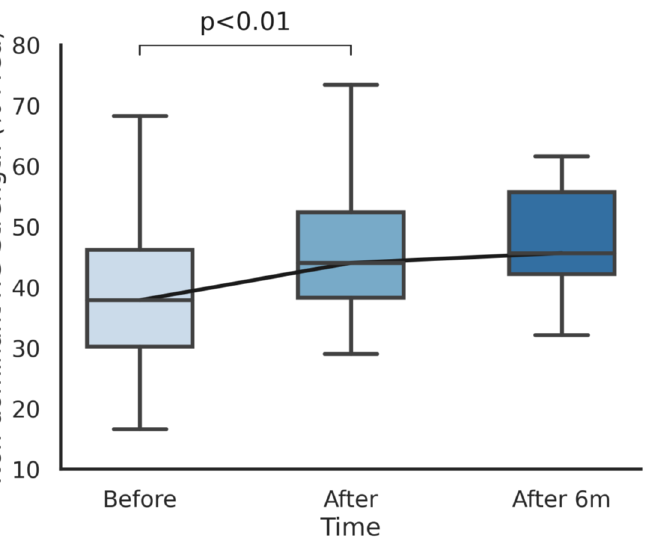
Figure 2. The percentage of predicted handgrip strength in the non-dominant hand before, after, and 6 months after the completion of the cardiopulmonary rehabilitation program.